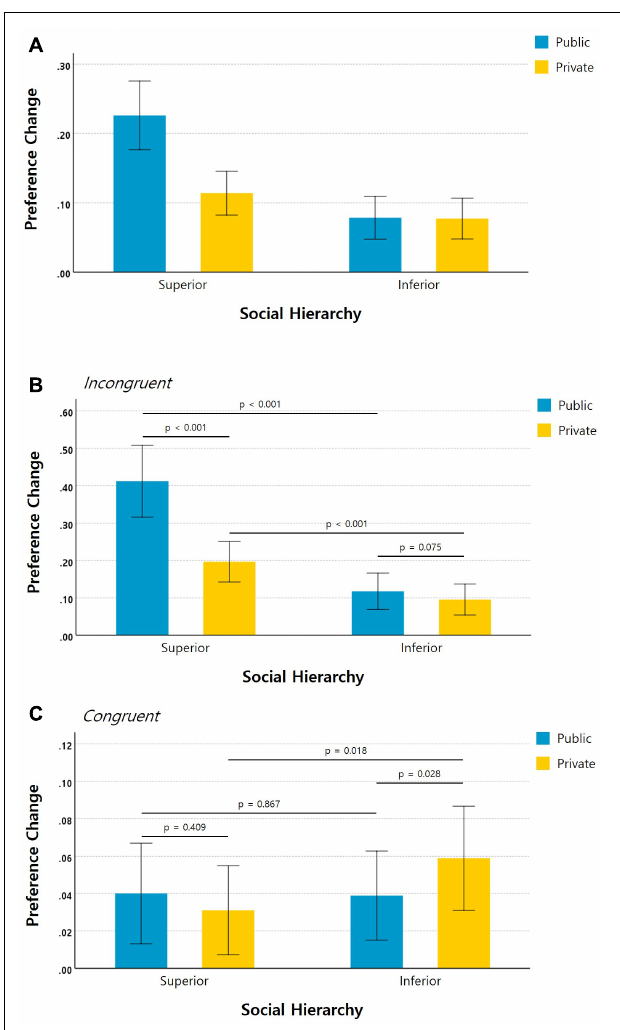
FIGURE 3 | Preference changes due to social hierarchy and anonymity. (A) The degree to which participants changed their preferences from the first rating to the second rating was significantly influenced by the rating of the superior under the public condition. The same data are shown separately for (B) incongruent and (C) congruent preference trials (error bars indicate 95% confidence intervals).